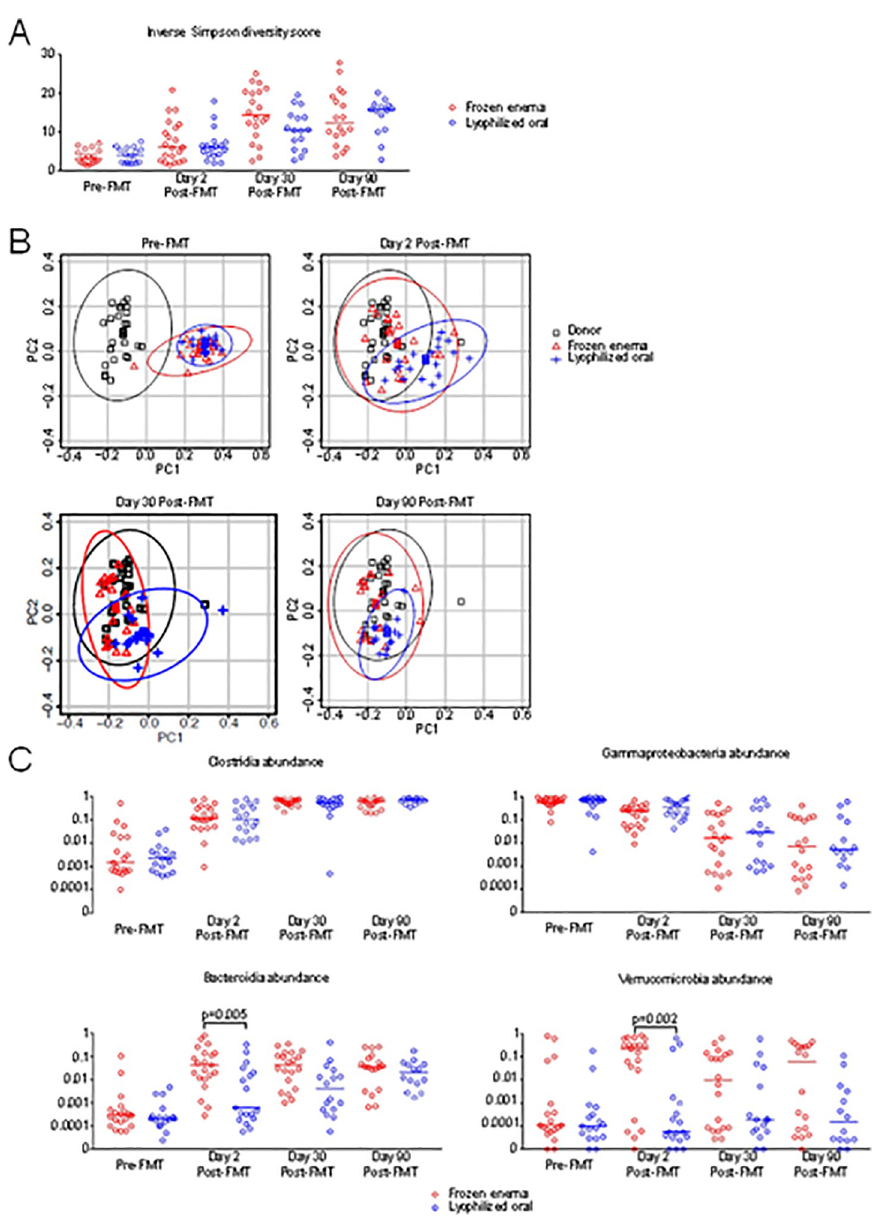
Fig 2. Microbiota analysis of 39 subjects before and after receiving FMT. A) Microbial diversity, quantified by the inverse Simpson index which combines measures of richness and evenness, of subject samples collected pre-FMT and post-FMT on the indicated time points. B) Principal Coordinate Analysis (PCoA) of UniFrac distances at specified time points, as well as donor samples. The axis PC1 explains 20.03% variation of the data and PC2 explains 6.13% variation of the data. Ellipses depict 95% confidence regions for each group. C) Bacterial abundance at the Class level of taxonomy of subject samples at indicated time points.